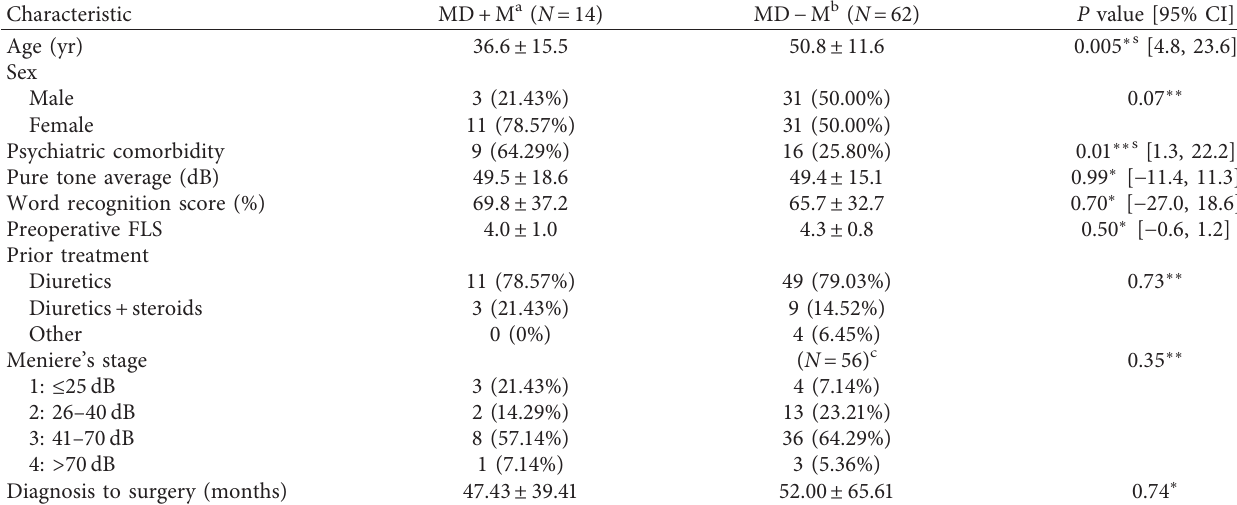
Table 1: All patient demographics stratified by migraine as a comorbidity.